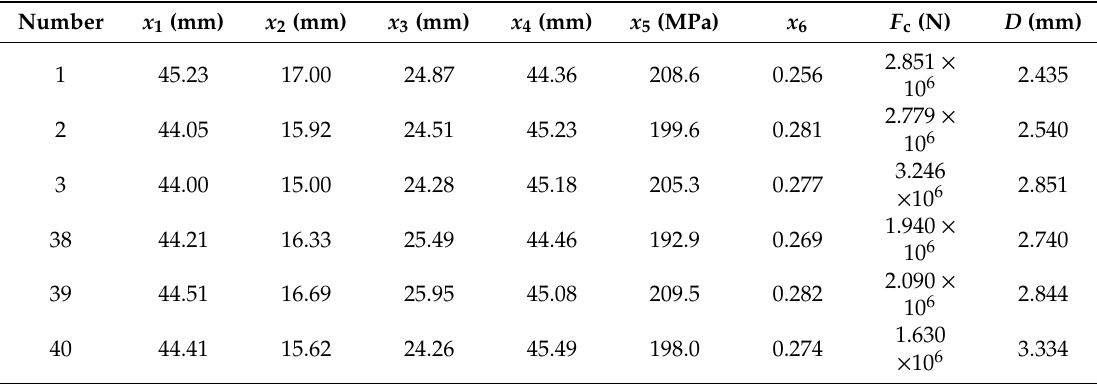
Table 7. Sample data and the corresponding